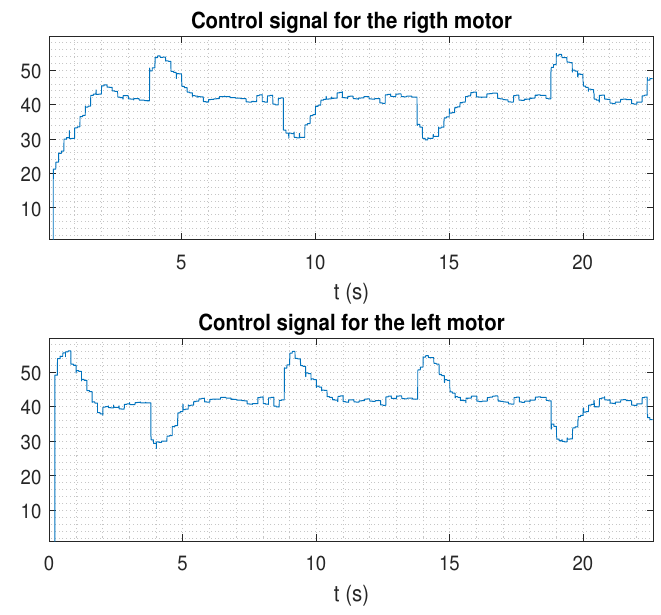
Figure 10. Control signal for the control proposal (EKF, prediction stage, and packet-based control) with delays and a lower level of noise.